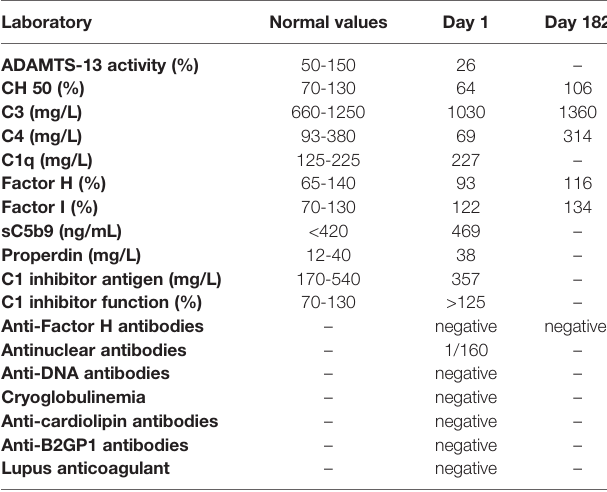
TABLE 2 | Immunological